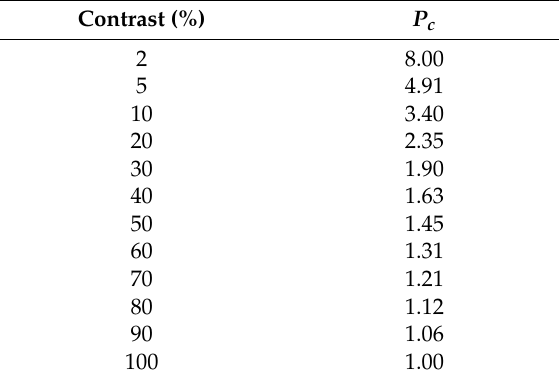
Table 1. Example coefficient values for map objects in